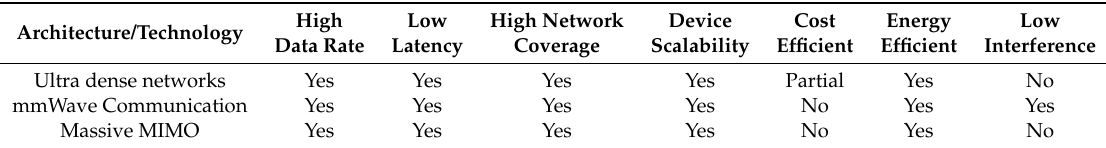
Table 1. Comparison of